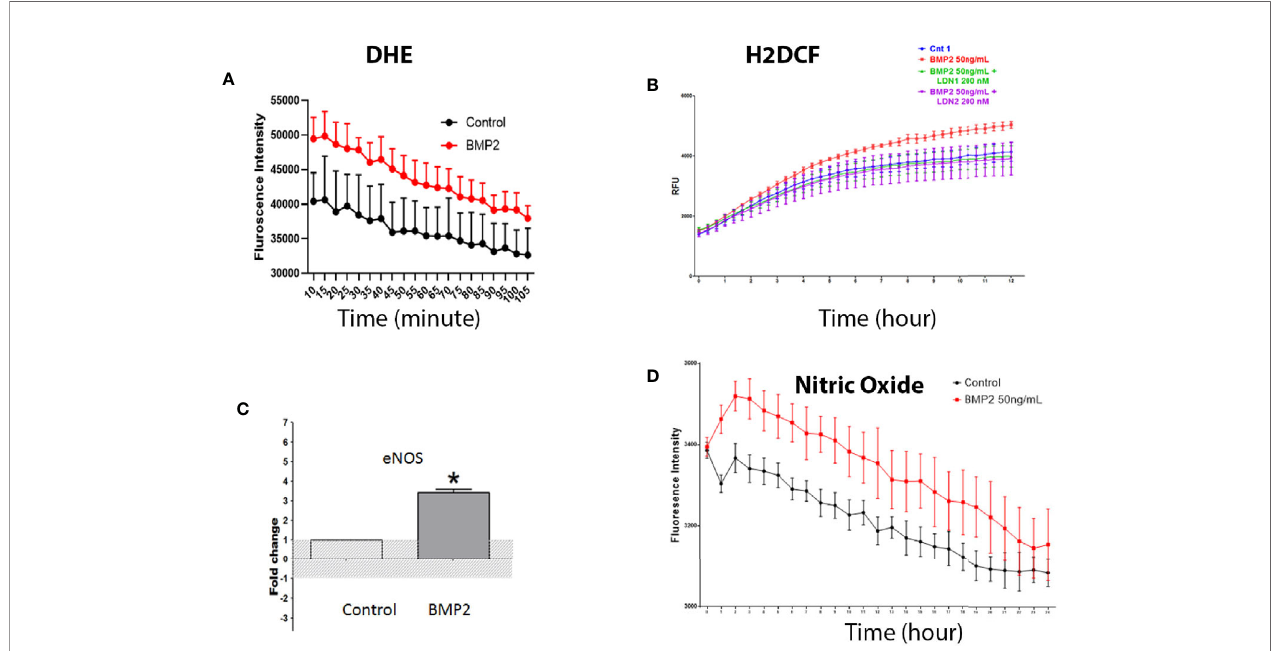
FIGURE 6 | Measurement of intracellular reactive oxygen species by dihydroethidium or DHE (A) and H2-Dichloro fl uorescine or DCF (B) showing signi fi cant increases in the superoxide and other ROS, respectively by BMP2. The increase in ROS was prevented by the pharmacological inhibitor of BMPR (LDN1). RT-PCR (C) showing signi fi cant increases in the levels of eNOS messenger RNA (mRNA) in the human retinal endothelial cells (HRECs) by BMP2. *p < 0.05. Finally, measurement of the eNOS activity by measuring nitric oxide (NO) generation using the fl uorescence reaction (D) showing signi fi cant increases by the BMP2. Differences among groups as represented by the mean ± SD were determined by the two-tailed t test or two way ANOVA followed by a post hoc Tukey ’ s